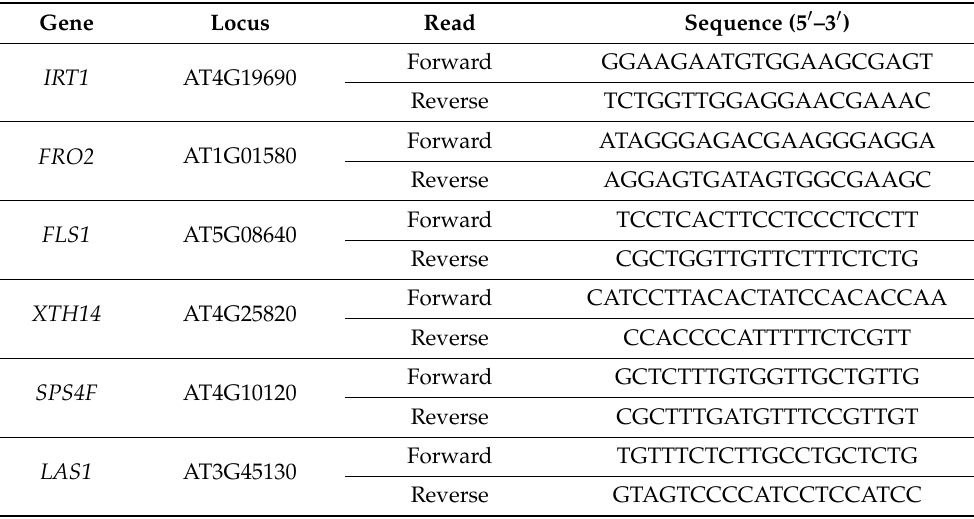
Table 1. Primers used in qRT-PCR procedure for gene expression level evaluation. Gene